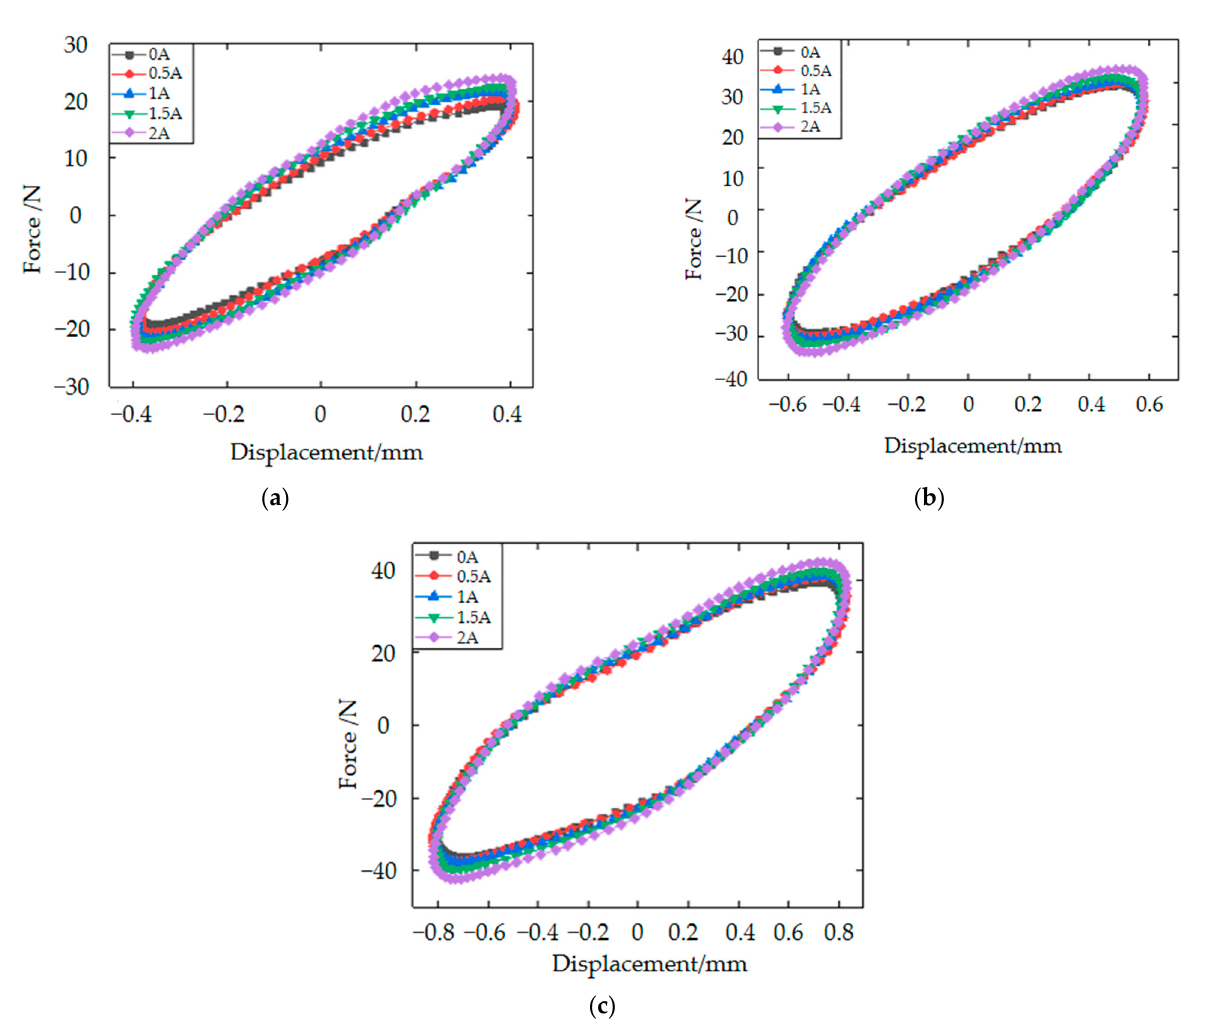
Figure 11. Force–displacement hysteresis loops in the horizontal direction of the MRE isolator for 8-Hz excitation: ( a ) 8 Hz, 0.4 mm; ( b ) 8 Hz, 0.6 mm and ( c ) 8 Hz, 0.8